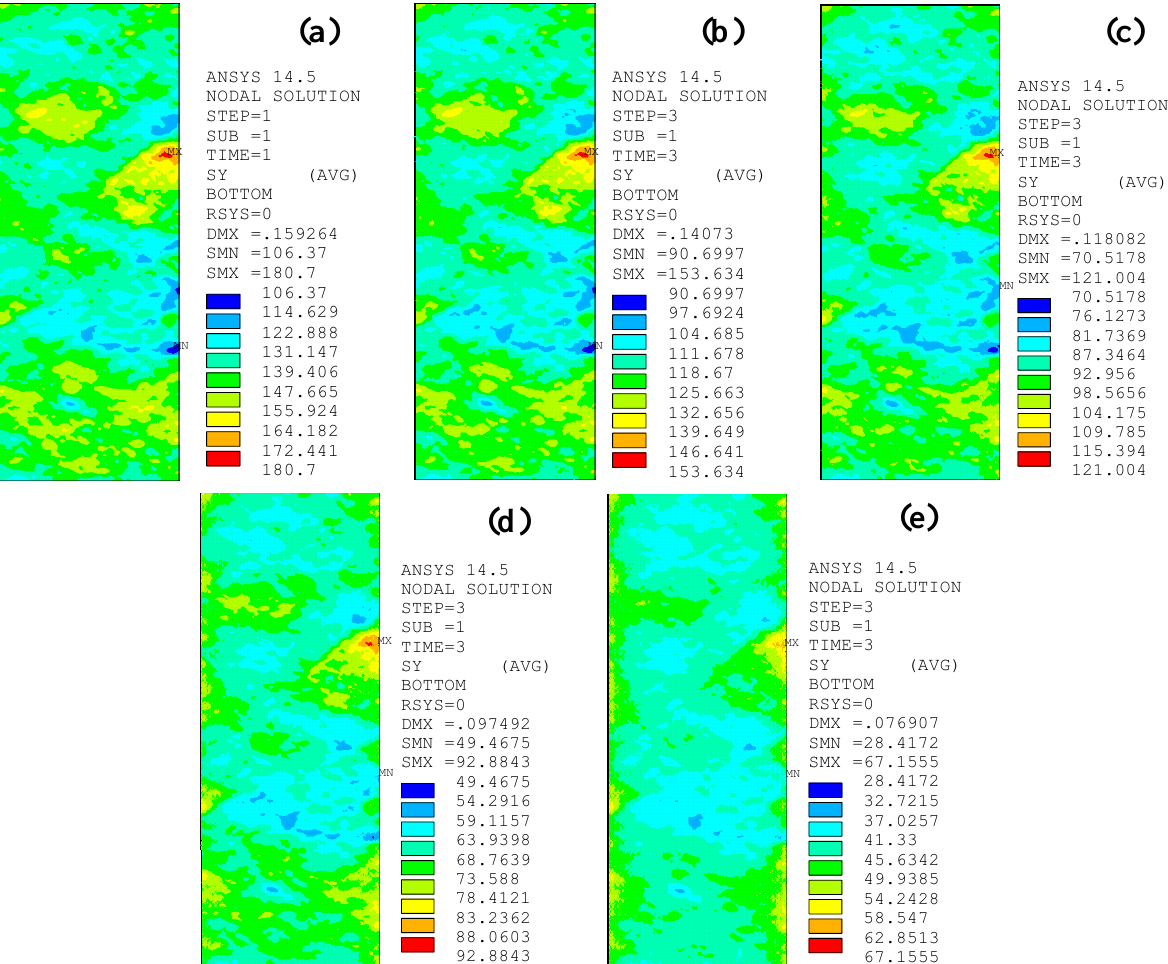
Figure 19. Peak tensile stress distribution on the corroded steel surfaces of the patched specimens with various prestress levels of CFRP plates: ( a ) C15-DS1.0-A0.5, ( b ) C15-DS1.0-A0.5-PS4.5, ( c ) C15-DS1.0-A0.5-PS10, ( d ) C15-DS1.0-A0.5-PS15, ( e ) C15-DS1.0-A0.5-PS20.